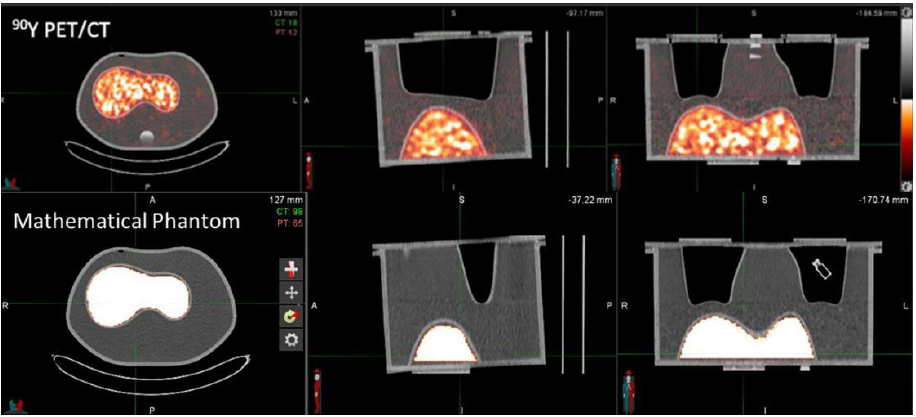
Figure 2. RC ( A ) and CoV ( B ) values for cylindrical phantom (black) and IEC NEMA Body phantom as functions of EI.